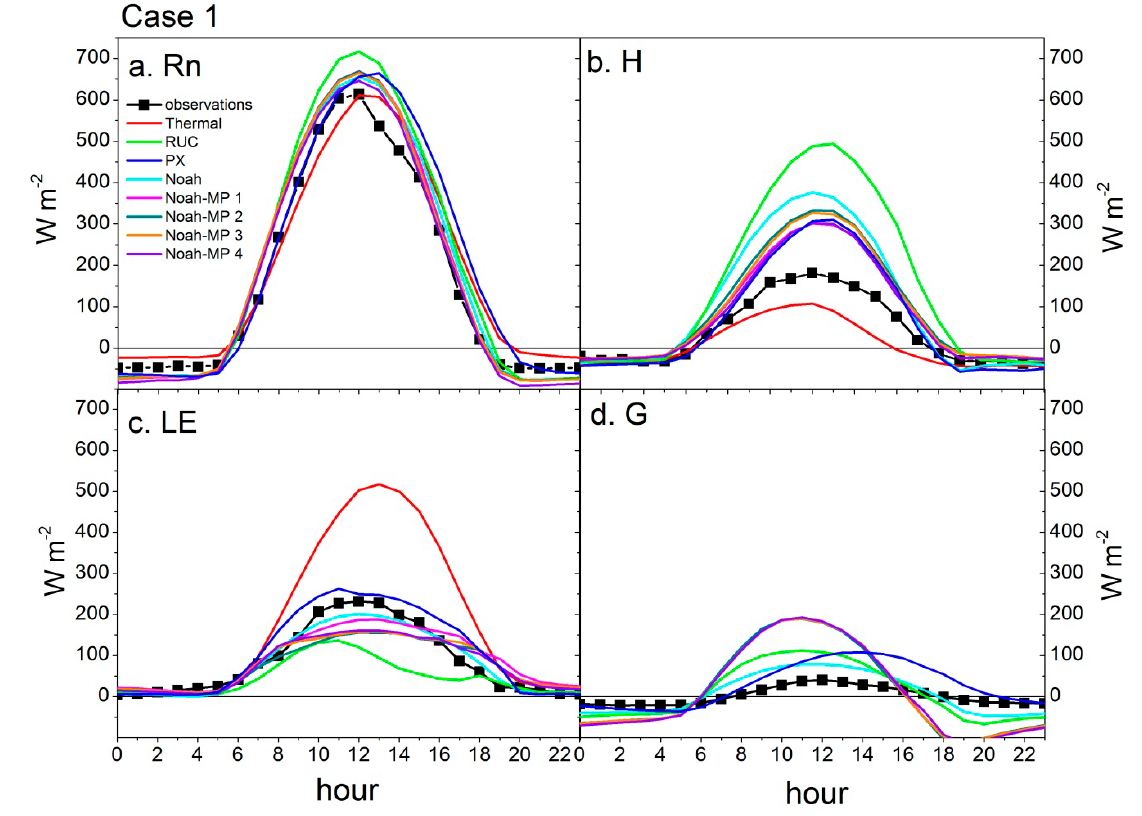
Figure 5. Mean diurnal plots of measured and simulated (a) net available energy (Rn), (b) sensible heat (H), (c) latent energy (LE), and (d) ground heat (G) fluxes for each LSM during Case 1 (June 2011). Positive H and LE fluxes indicate net energy transfer to the atmosphere. Positive G fluxes indicate net energy transfer to the ground surface. Time is given in Local Standard